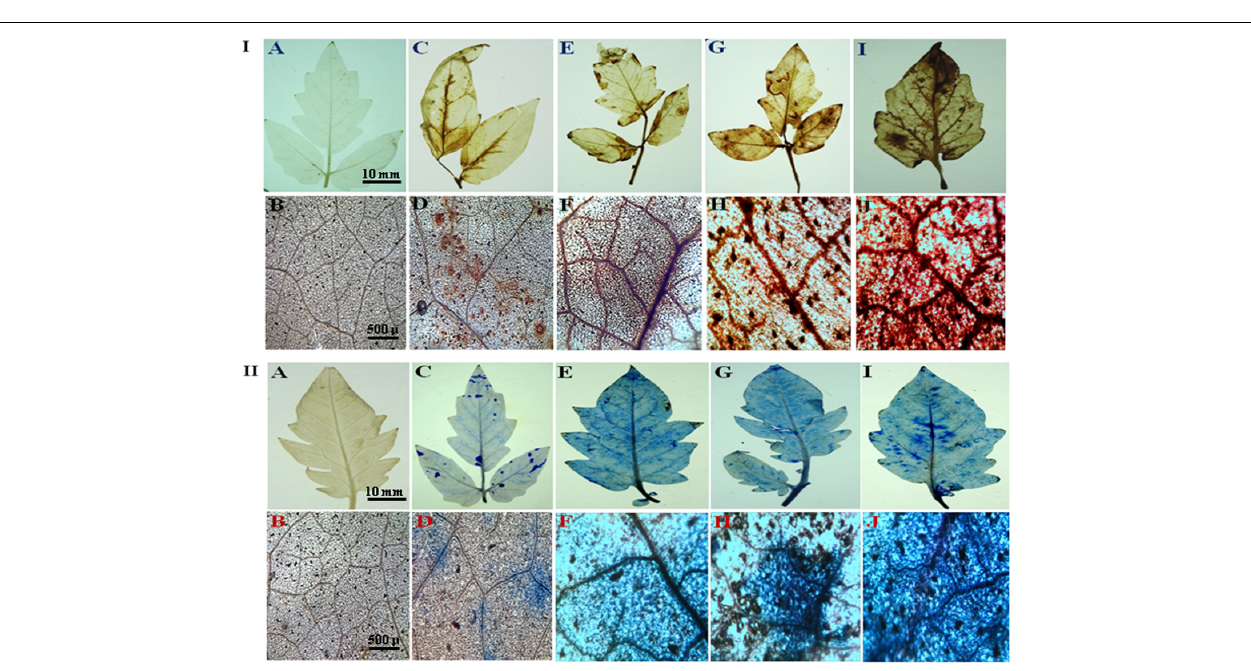
FIGURE 5 | (I) Hydrogen peroxide production in tomato leaves as visualized by DAB staining. (A) control leaf; (B) microscopic view; (C) AME treated leaf; (D) microscopic view; (E) AOH treated leaf; (F) microscopic view; (G) TeA treated leaf; (H) microscopic view; (I) pathogen infected leaf; (J) microscopic view. (II) Cell death assay by Evans blue staining. (A) control leaf; (B) microscopic view; (C) AME treated leaf; (D) microscopic view; (E) AOH treated leaf; (F) microscopic view; (G) TeA treated leaf; (H) microscopic view; (I) pathogen infected leaf; (J) microscopic view.